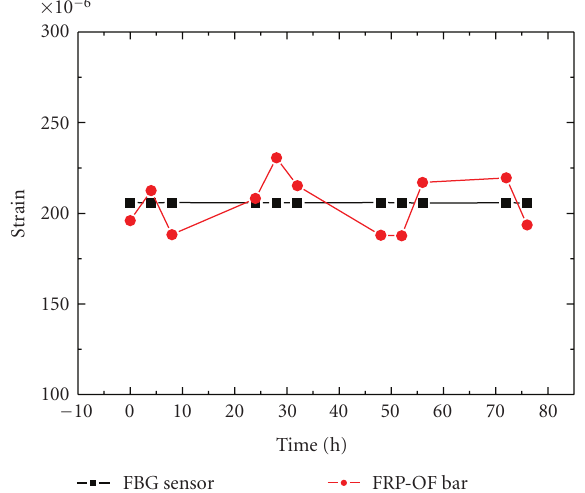
Figure 13: Strain comparison from FBG sensor and the FRP-OF